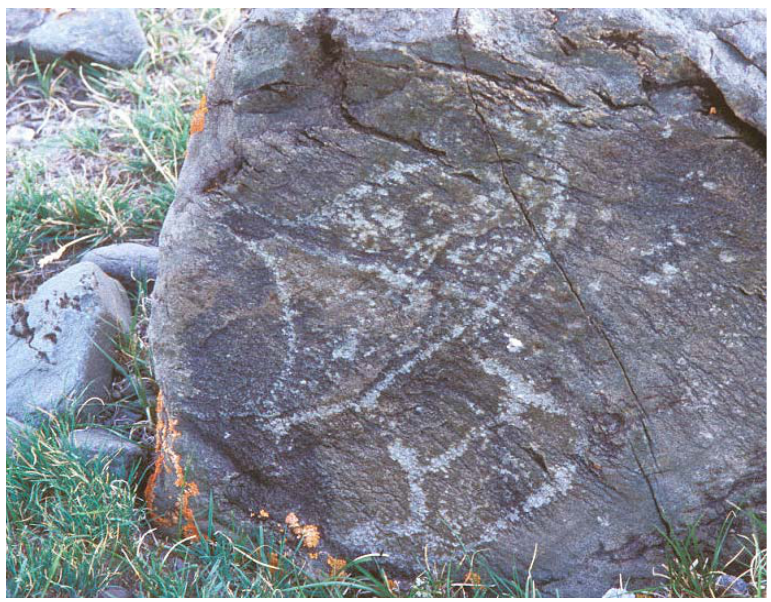
Figure 9. Inverted bear and horse on tumbled boulder. Pre-Bronze Age (Paleolithic period). Tsagaan Salaa V.